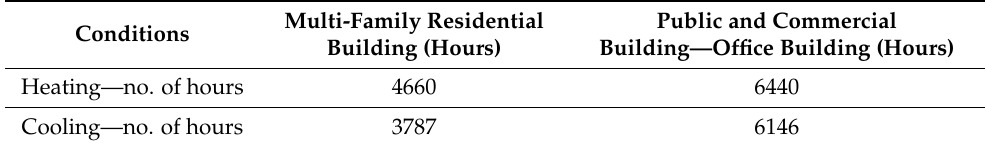
Table 5. Number of heating and cooling hours for different building